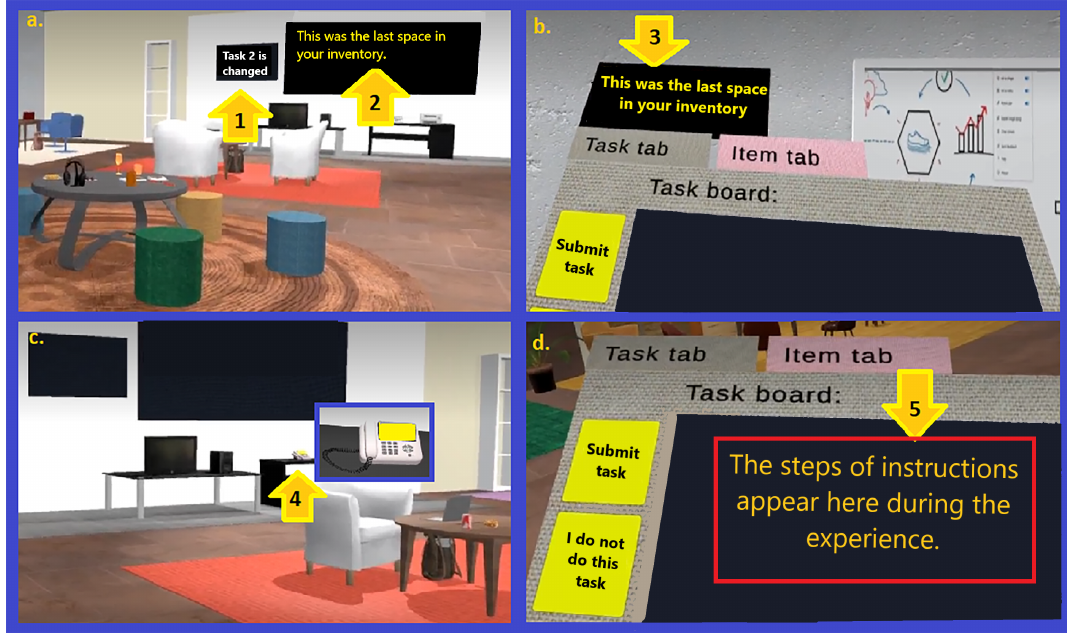
Figure 4. Screenshots showing five sources of information for the user during the experience: ( a ) Arrow 1 points to a small blackboard that displays the name of the current task. Arrow 2 points to a big blackboard that communicates the current status of the tasks during the experience; ( b ) Arrow 3 points to a small blackboard attached to the panel that is a closeup of the big one; ( c ) Arrow 4 points to a phone that blinks and rings when the boss calls; ( d ) Arrow 5 points to a task board that shows the instructions for each